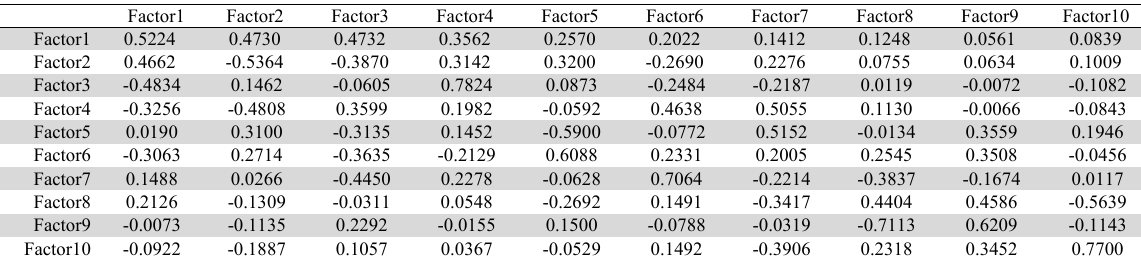
The information of rotation matrix